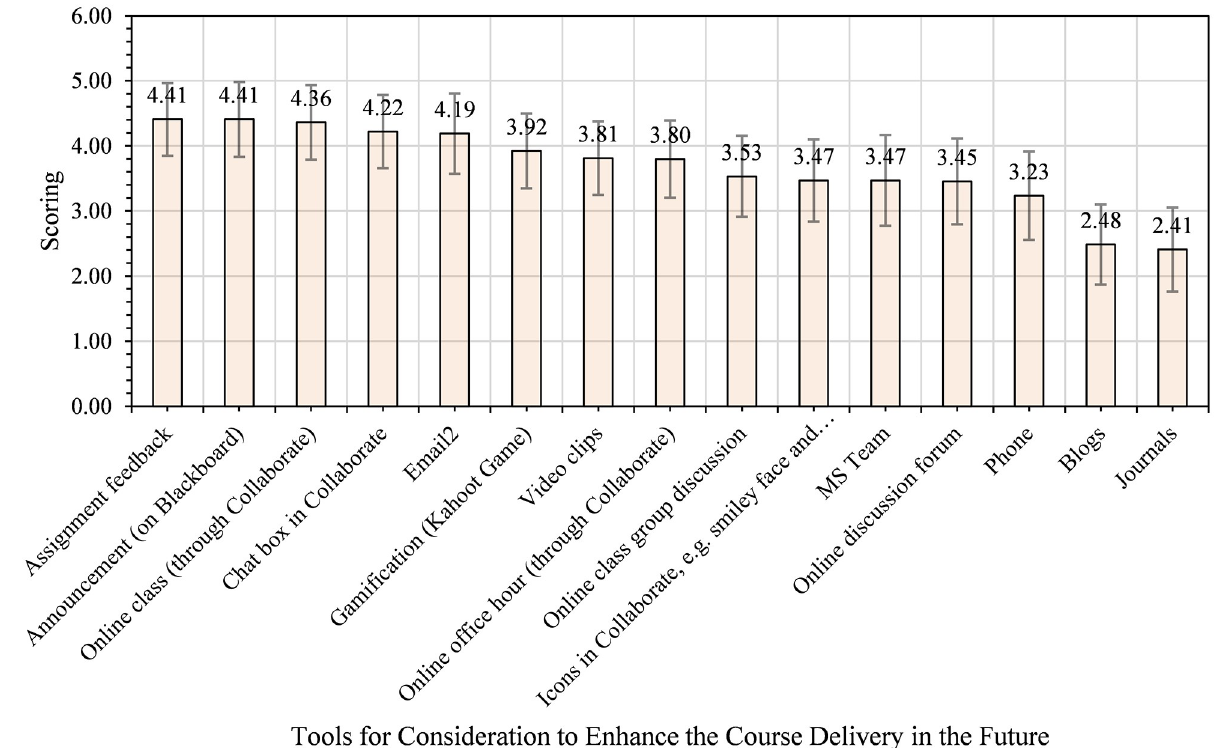
Fig 6. Students’ views on tools for consideration to enhance the course delivery in the